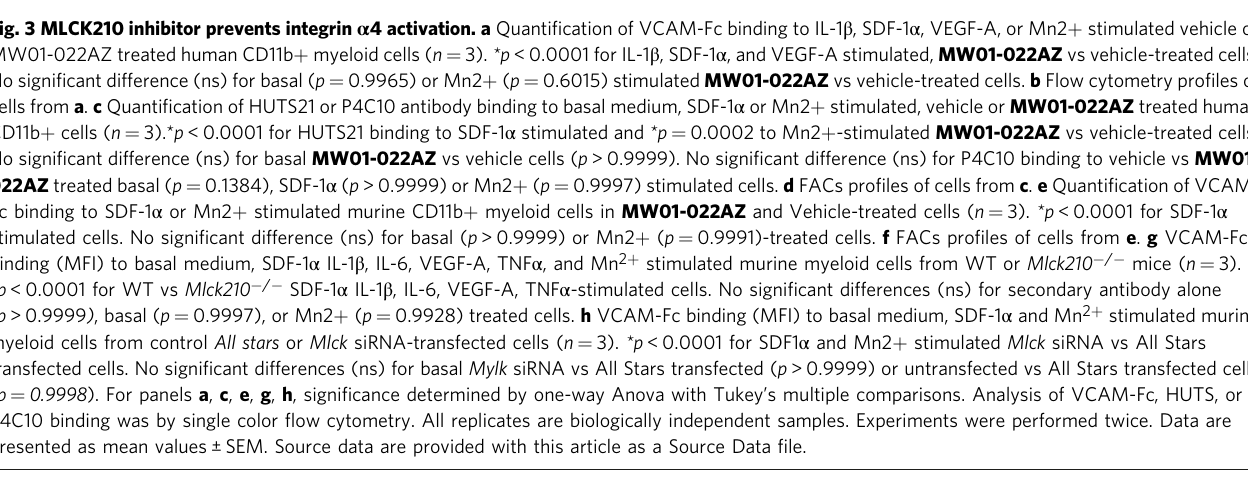
Fig. 3 MLCK210 inhibitor prevents integrin α 4 activation. a Quanti fi cation of VCAM-Fc binding to IL-1 β , SDF-1 α , VEGF-A, or Mn2 + stimulated vehicle or MW01-022AZ treated human CD11b + myeloid cells ( n = 3). *p < 0.0001 for IL-1 β , SDF-1 α , and VEGF-A stimulated, MW01-022AZ vs vehicle-treated cells. No signi fi cant difference (ns) for basal ( p = 0.9965) or Mn2 + ( p = 0.6015) stimulated MW01-022AZ vs vehicle-treated cells. b Flow cytometry pro fi les of cells from a . c Quanti fi cation of HUTS21 or P4C10 antibody binding to basal medium, SDF-1 α or Mn2 + stimulated, vehicle or MW01-022AZ treated